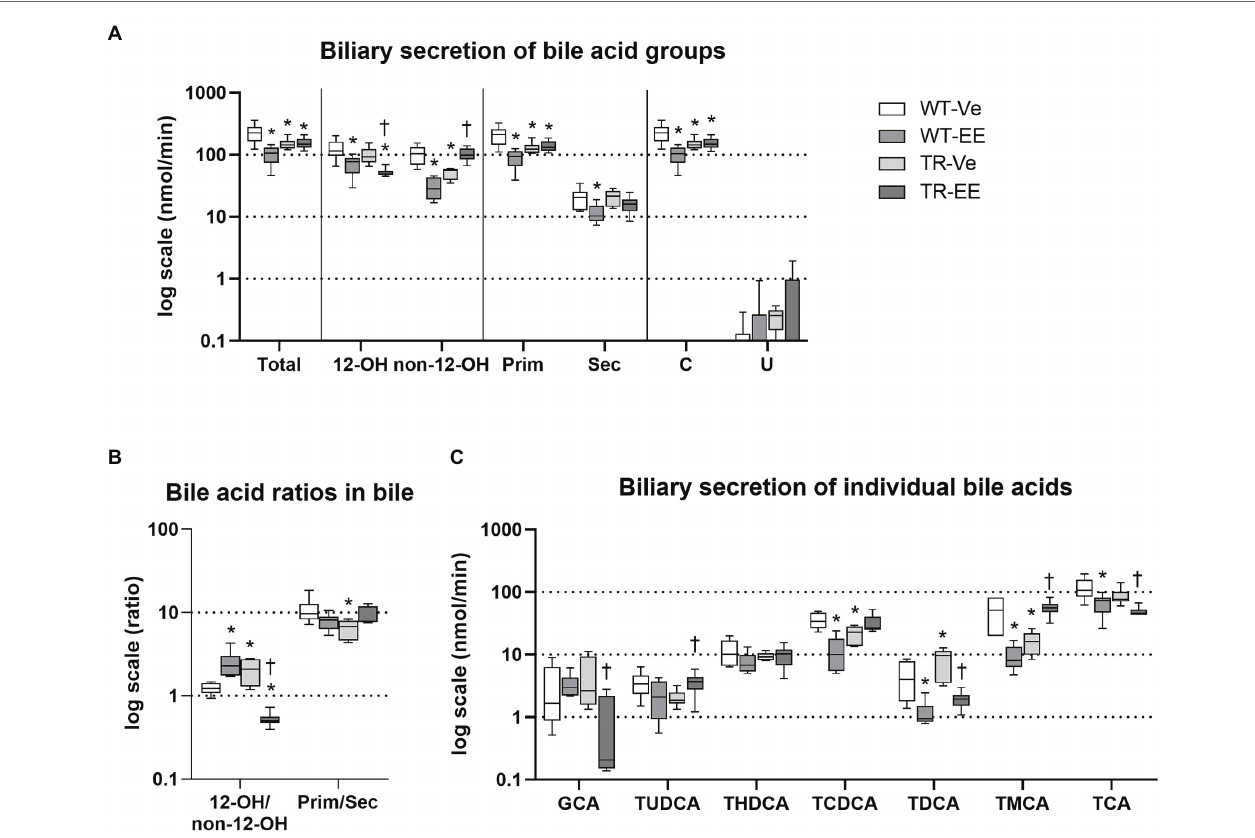
FIGURE 3 | Ethinylestradiol administration reduced biliary secretion of bile acids (BAs) in WT and TR animals. Experimental groups: WT-Ve, WT rats receiving vehicle; WT-EE, WT rats receiving ethinylestradiol; TR-Ve, TR rats receiving vehicle; and TR-EE, TR rats receiving ethinylestradiol. (A) Biliary secretion of different types of BAs. (B) Biliary ratios of essential bile acid groups. (C) Biliary secretion of individual bile acids. Data are presented as medians, with boxes and whiskers representing the interquartile range and 5th-95th percentiles, respectively. Significance: * p < 0.1 compared to vehicle-treated WT rats; † p < 0.05 compared to vehicle- treated TR group. BA: 12 α -hydroxylated (12-OH), non-12 α -hydroxylated (non-12-OH), primary (Prim), secondary (Sec), conjugated (C), glycocholic acid (GCA), ursodeoxycholic acid (UDCA), hyodeoxycholic acid (HDCA), chenodeoxycholic acid (CDCA), deoxycholic acid (DCA), muricholic acid (MCA), and cholic acid (CA), with taurine conjugates TUDCA, taurohyodeoxycholic acid (THDCA), taurochenodeoxycholic acid (TCDCA), taurodeoxycholic acid (TDCA), tauro-muricholic acid (TMCA), and taurocholic acid